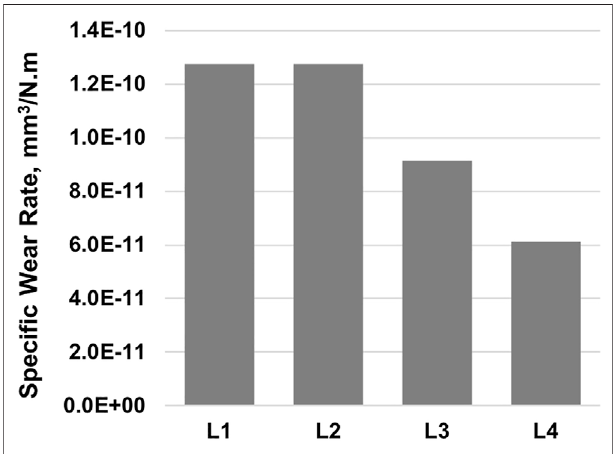
FIGURE 8 | Speci fi c wear rate of the pin for various